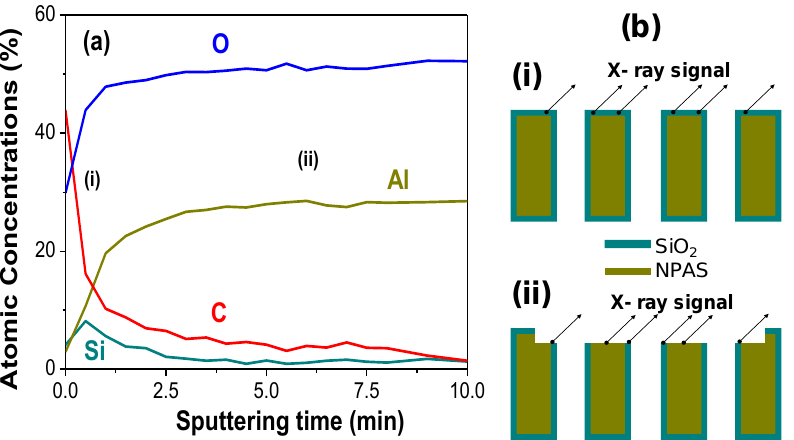
Figure 2. ( a ) Variation of the atomic concentration percentages of silicon, aluminum, carbon, and oxygen with the XPS sputtering time for the NPAS + SiO 2 sample; ( b ) schemes of the XPS depth-profile analysis for: (i) the external surface, and (ii) during the argon etching process for the NPAS + SiO 2 sample.